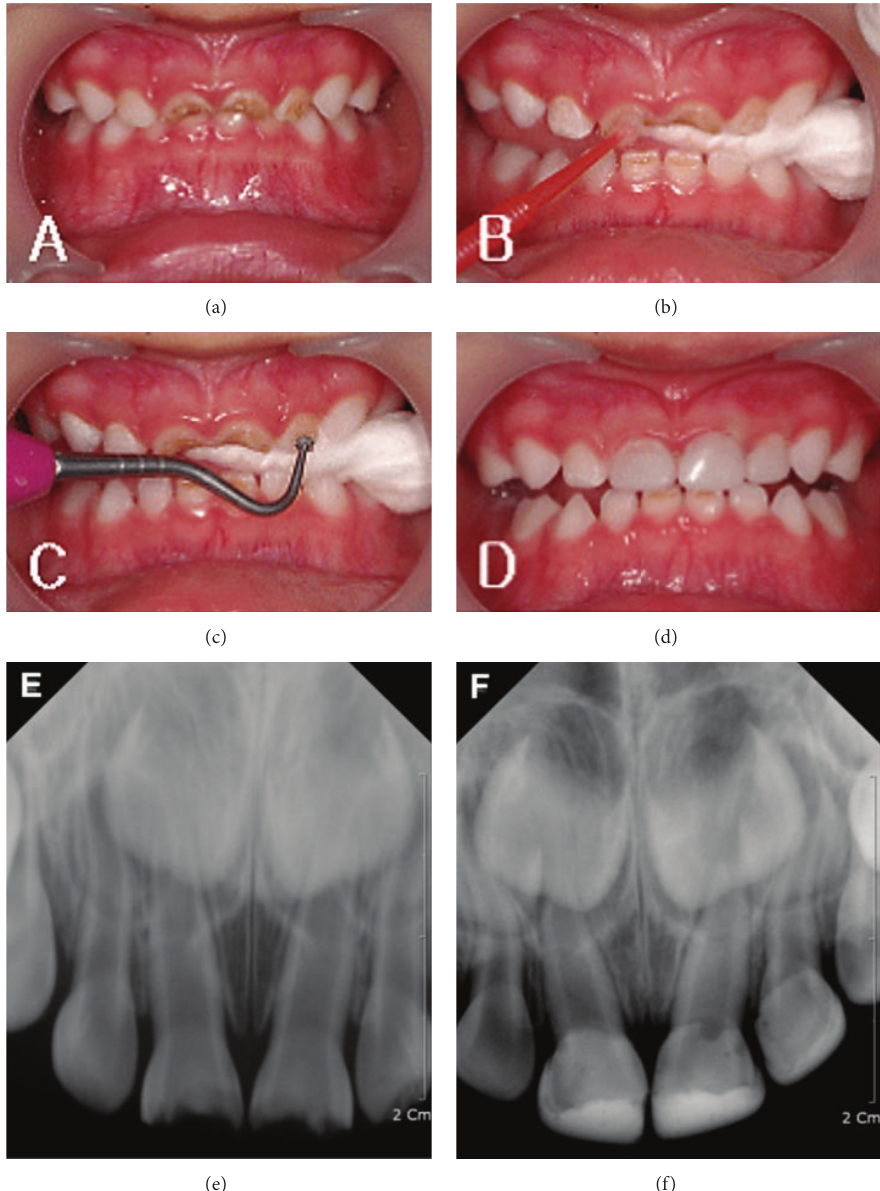
Figure 2: (a) Oral status of the patient before treatment, (b) application of Carigel, (c) removal of dental caries, (d) restoration with RelyX Unicem, (e) radiograph of the patient before treatment, and (f) radiograph of the patient treatment after 8